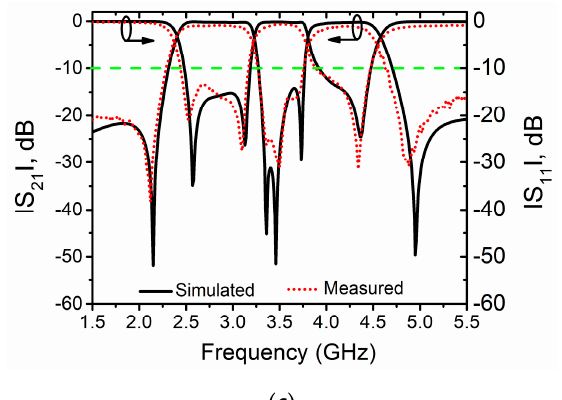
Figure 9. Filter responses with respect to ( a ) Case B: C F = 4.7 pF, C S = 2.4 pF, C T = 100 pF; ( b ) Case C: C F = 100 pF, C S = 100 pF, C T = 100 pF; ( c ) Case D: C F = 100 pF, C S = 2.4 pF, C T = 2.2 pF.